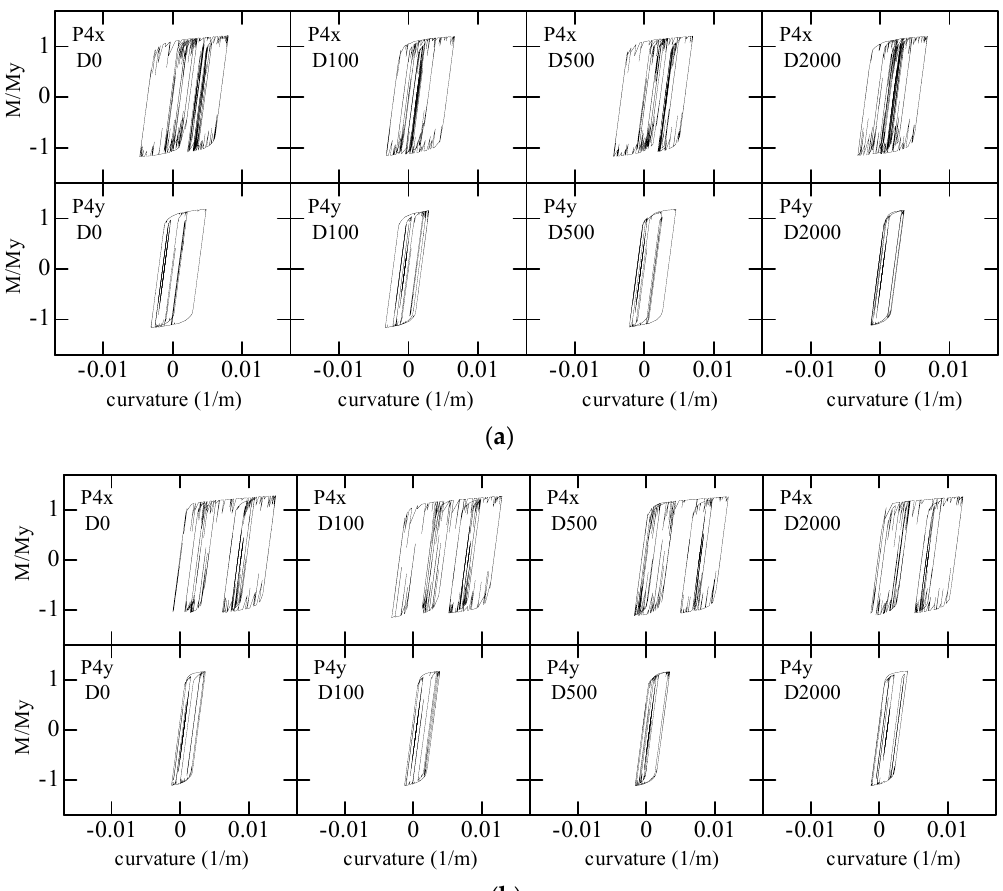
Figure 17. Hysteretic curve of bending moment to curvature at pier bases (P4). ( a ) Stopper = 4 cm. ( b ) Stopper = 8 cm.